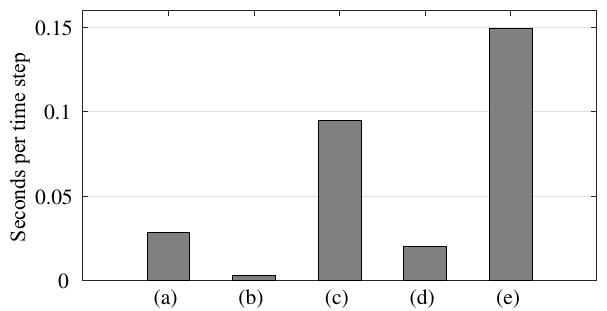
Figure 4. Individual timing of the four modules of the time loop averaged over 10k steps: (a) velocity gradient, (b) SGS, (c) con- vective term, (d) Poisson solver, and (e) total time loop. The numer- ical resolution is 128 3 , run with 64 MPI processes and a domain decomposition of 8 ×